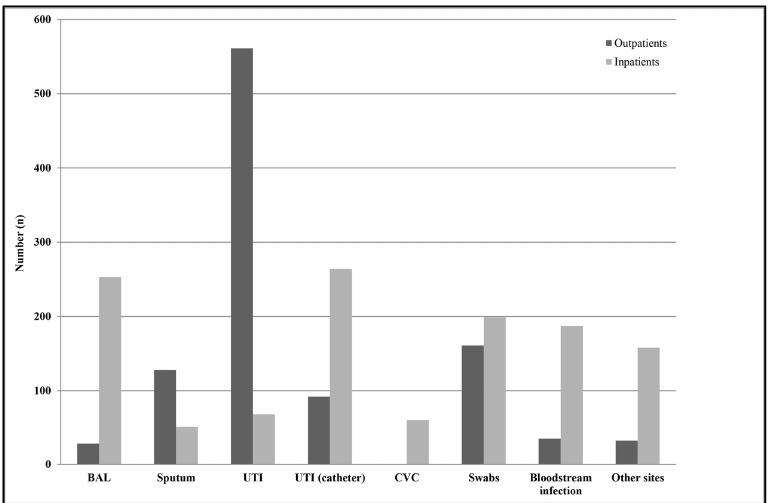
Figure 2. Distribution of Enterobacter spp. isolates by infection type among outpatients and hospital- ized subjects. Swabs were from different anatomical sources, such as the nose, throat, groin, hears, and wounds. Other sites included samples from ascetic and peritoneal fluids. Abbreviations: BAL, Bronchoalveolar lavage; UTI, urinary tract infections; UTI (catheter), catheter-associated urinary tract infection; CVC, central venous